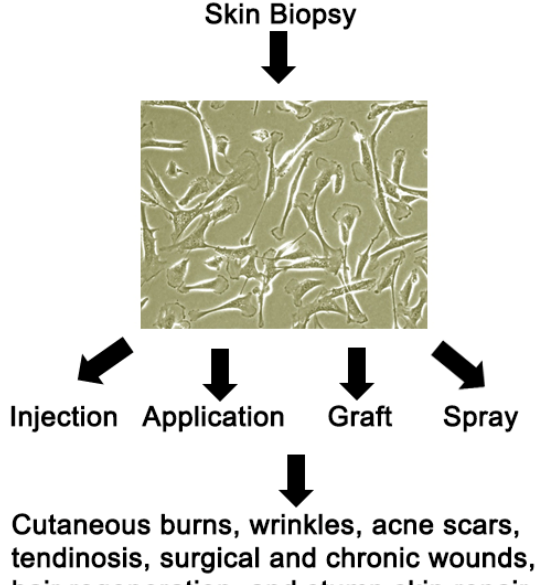
Figure 1. Flow diagram of harvesting skin, growing fibroblasts, and injecting for different uses. The location of the skin biopsy for growing fibroblasts may be directed by the therapeutic